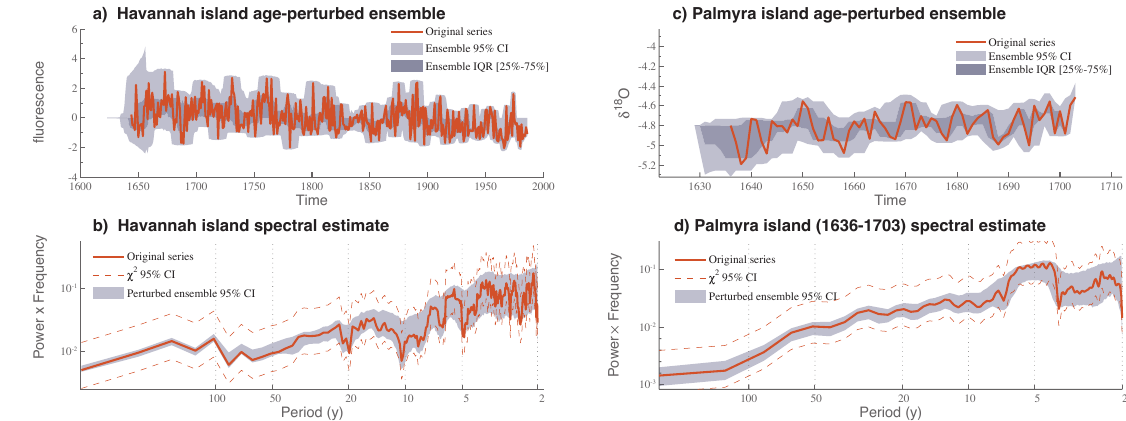
Fig. 3. Ensemble realization (top) and power spectra (bottom) of age-perturbed coral data for (a,b) Havannah Island (Isdale et al., 1998) and (c,d) Palmyra Island δ 18 O record from 1636 to 1703 (Cobb et al., 2003), where the top layer is U / Th dated. The original data and corresponding spectral estimates are shown in red, and the 95% confidence intervals (CIs) and the 25–75% interquartile range (IQR) of the perturbed data ensemble and corresponding spectra are shown by the shaded areas. Power spectra are represented in variance-preserving coordinates (that is, the area under the curve is an exact measure of the variance contained in each frequency band). error rates as in the previous section ( θ 1 = θ 2 = 0 . 05).